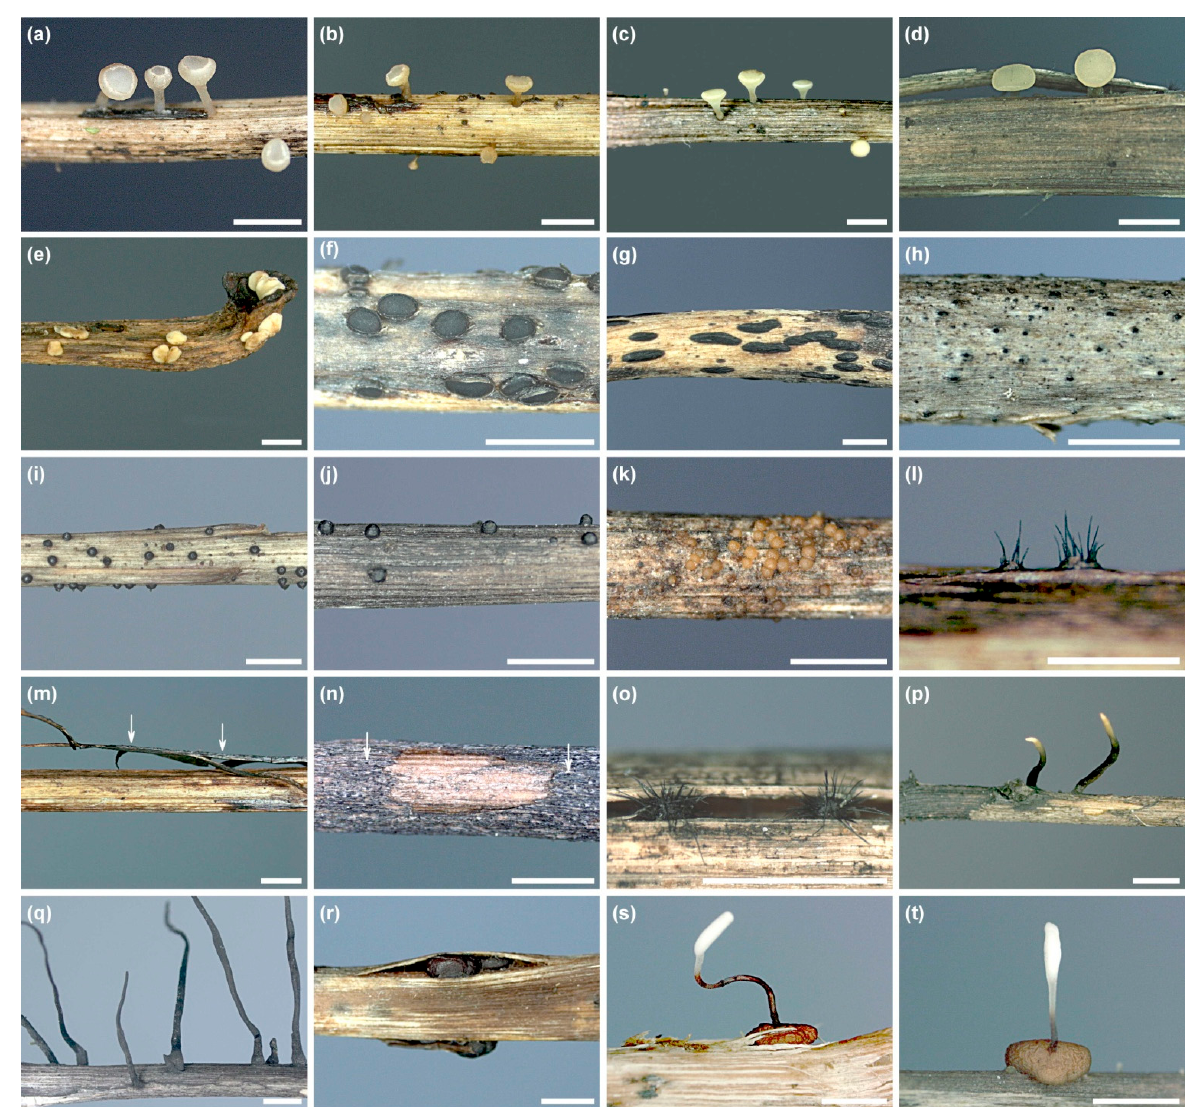
Figure 6. Fungal fruit bodies on the previous year’s leaf petioles of F. excelsior in the litter, in 2017: ( a – f ) apothecia: a— Cyathicula fraxinophila , ( b ) Cyathicula sp. 2, ( c ) Hymenoscyphus caudatus , ( d ) Hymenoscyphus scutula , ( e ) Helotiales sp. 1, ( f ) Pyrenopeziza petiolaris , ( g ) Hypoderma rubi , hysterothecia and pycnidia, ( h ) Paraophiobolus arundinis pseudothecia, ( i ) Leptosphaeria sp. 2, pseudothecia, ( j ) Leptosphaeria sclerotioides , pycnidia, ( k ) Neonectria sp. 2, perithecia, ( l – n ) Venturia fraxini , with setae lining the ostiolum of the pseudothecium ( l ), pseudothecia on the exfoliated periderm ( m ), pseudothecia on petioles with damage made by small fauna ( n ), ( o ) setaceous pycnidia of Pyrenochaeta sp., ( p ) anamorph of Xylaria sp. 1, ( q ) anamorph of Xylaria sp. 3, ( r , s )— Typhula sp. 2, sclerotia ( r ) and carpogenic sclerotium ( s ), ( t ) Typhula erythropus , carpogenic sclerotium.